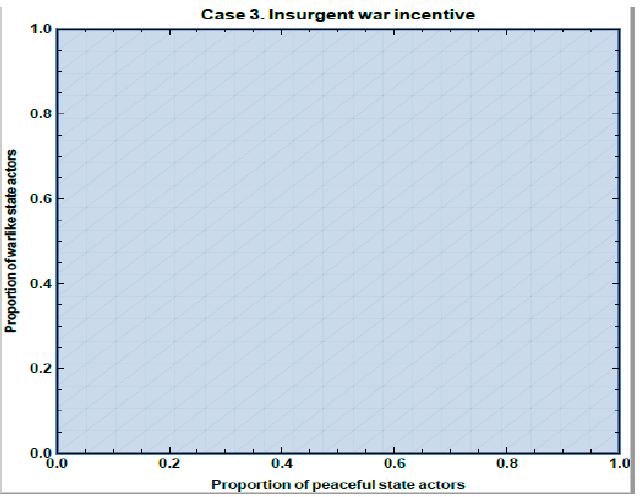
Figure 5. Fitness for Insurgents when r = 0.3, δ = 0.99, c = 0.2, p = 0.5.